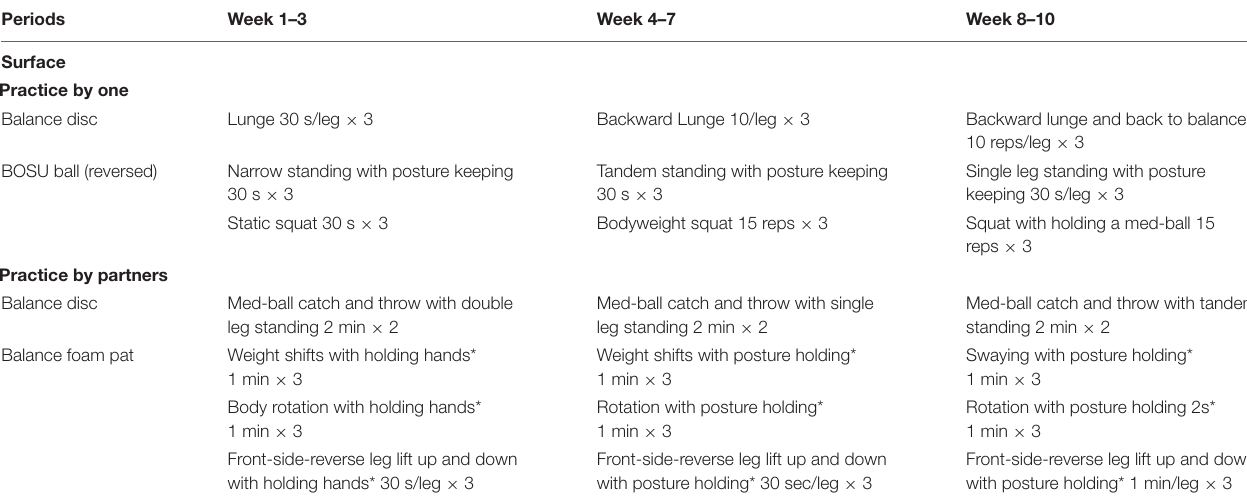
TABLE 2 | Neuromuscular training program (repetitions/duration ×